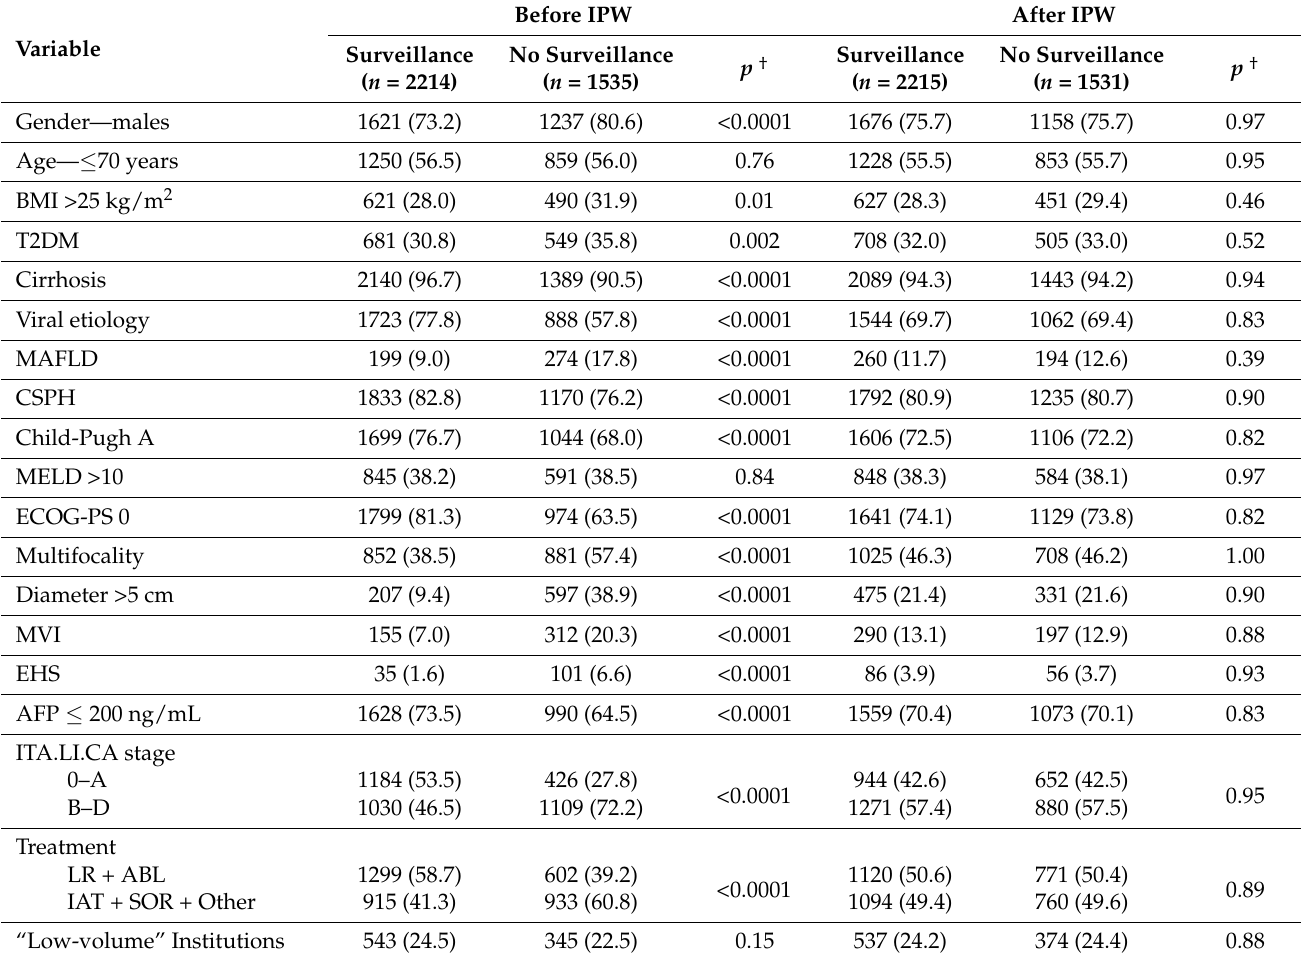
Table 3. Baseline characteristics of surveillance and no surveillance groups before and after inverse probability